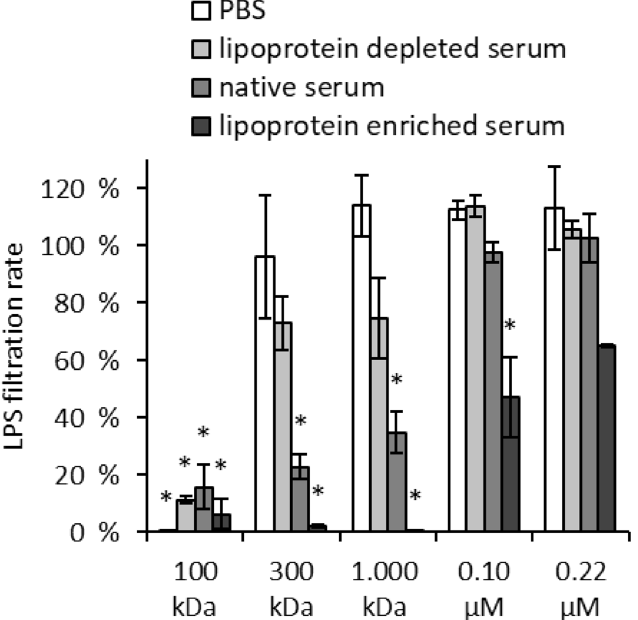
Figure 12. Influence of lipoproteins on the filtration rate of endotoxin. 5 ng/mL LPS ( E. coli ) were dissolved in PBS, lipoprotein-depleted serum, native serum and lipoprotein-enriched serum and filtered through spin columns with 100, 300 and 1000 kDa MWCO. Additionally, the samples were filtered through a 0.1 µm and 0.22 µm sterile filter. The figure shows the percentage of endotoxin values measured in the filtrate samples compared to the unfiltered samples (N = 3).